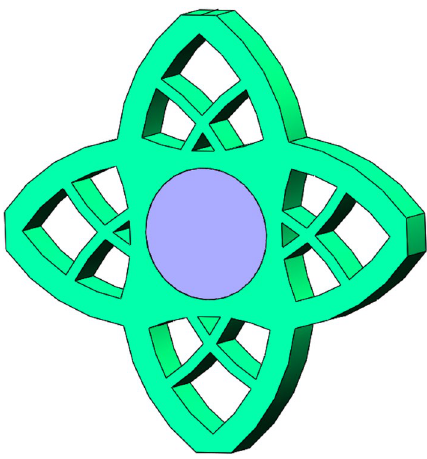
Figure 19. CAD software reconstructed